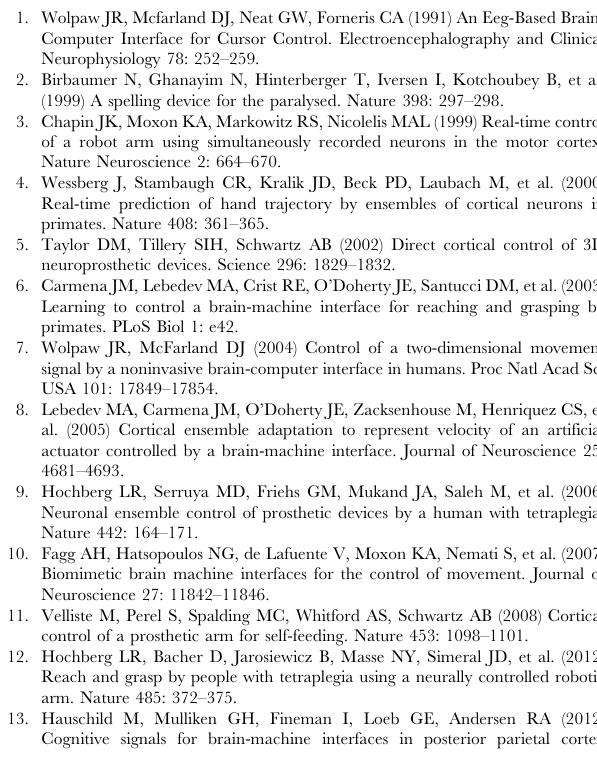
Figure S3 Decoding results for monkey A in three dimensional space. A) Example of 3D hand trajectory prediction for one trial movement using 3 electrodes. The predicted and observed trajectories in 3D space are depicted in blue and red, respectively. The unfilled circles represent the start point of movement. The two triangles mark hand position at equivalent time points during movement. Solid circles denote the end point of movement. B, C, and D) The predicted (blue) and observed (red) trajectories shown in the X–Y, X–Z, and Y–Z planes, respectively. Figure S4 Decoding results for monkey A with different electrode numbers selected using the location-based method. Example prediction of 3D hand positioning over 8 s of test data using 3, 6, 9, 12, and 15 electrodes. The red solid line depicts actual trajectories. The green solid line, purple dotted line, light blue dotted line, brown dotted line, and blue solid line represent predicted trajectories using 3, 6, 9, 12, and 15 electrodes,